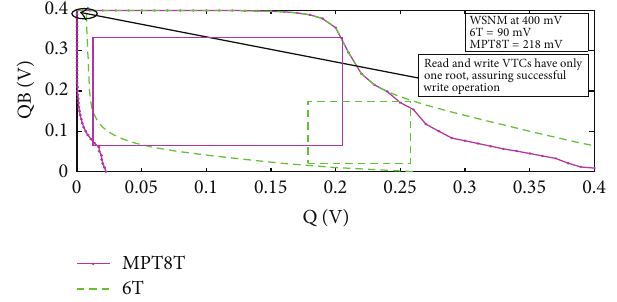
Figure 16: The combined read and write VTC curve for WSNM of MPT8T and 6T.